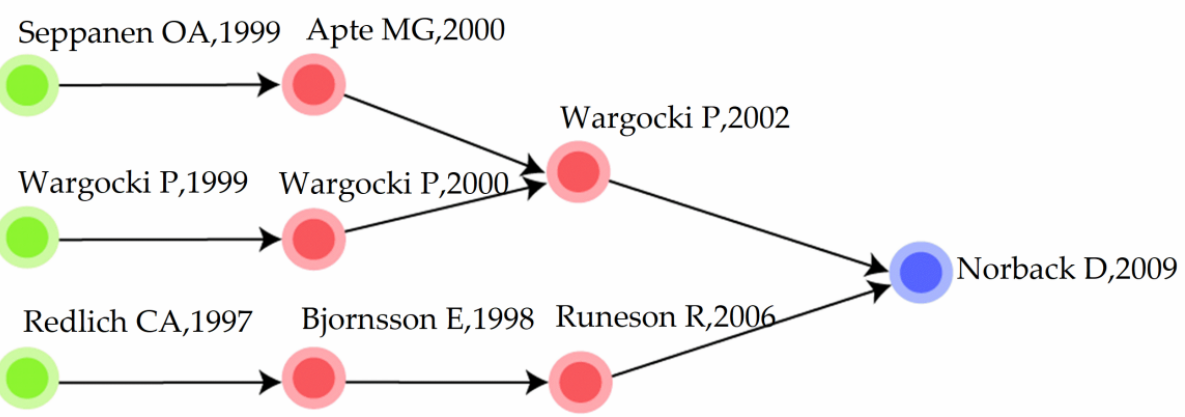
Figure 9. Phase path analysis of the SBS from 1997 to 2009 [30 – 32,35 – 38,44 – 45].